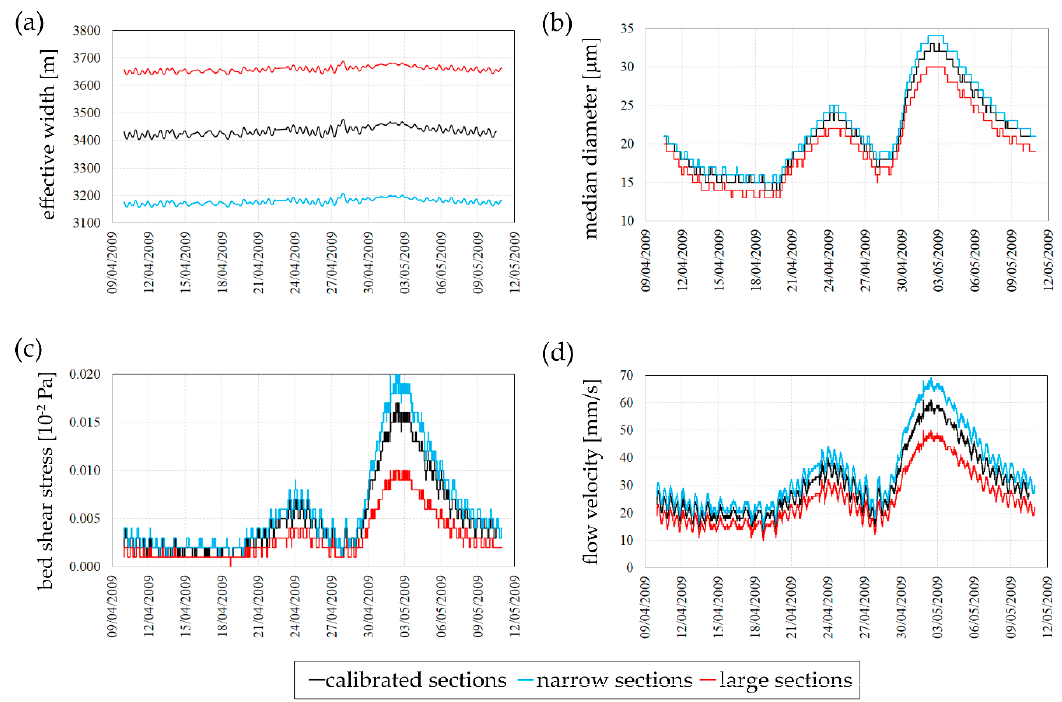
Figure 8. Comparison between calibrated (black line), narrow (blue line) and large (red line) sections at the E16 core location: (a) effective width W ; (b) median diameter d 50 ; (c) bed shear stress τ ; (d) averaged flow velocity v .